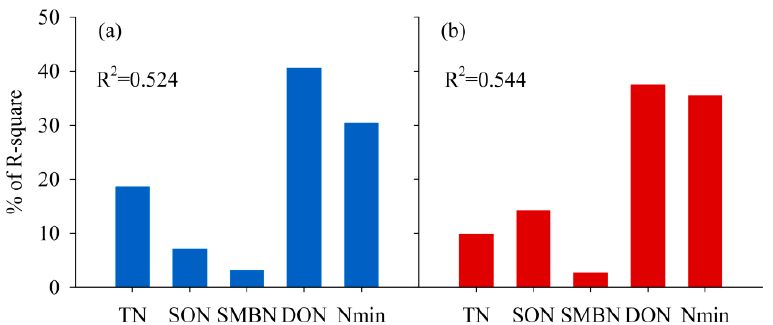
Figure 6. Relative influences of soil nitrogen (N) fractions on ( a ) dry matter production and ( b ) N uptake of maize. TN, total N; SON, soil organic N; SMBN, soil microbial biomass N; DON, dissolved organic N; N min , mineral N.